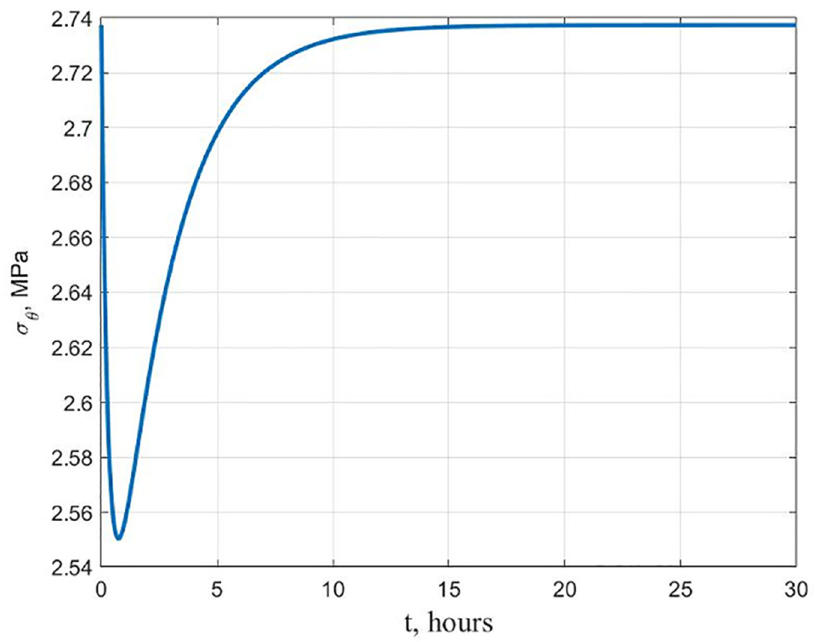
Figure 5. Variation in time of stresses σ θ at the inner surface of the homogeneous cylinder.